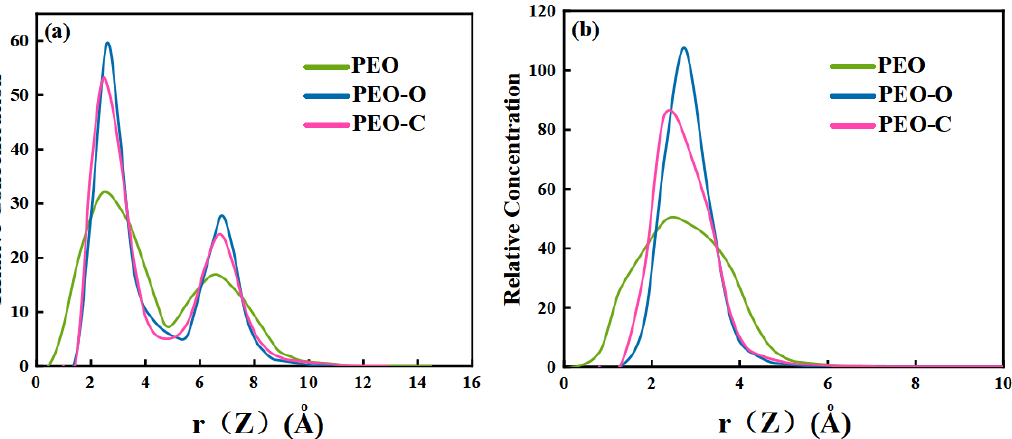
Figure 13. The relative concentration distributions of oxygen and carbon atoms of PEO and PEO ( a ) kaolinite 001 surface and ( b ) Kaolinite 00 1̅ surface.